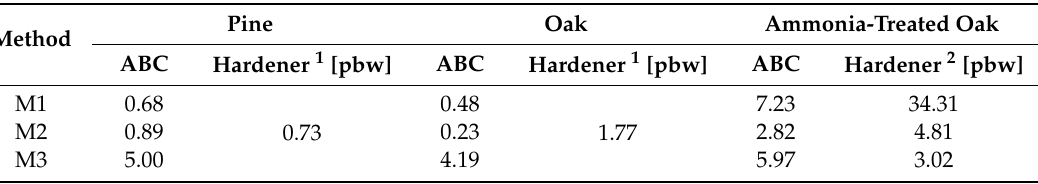
di ff erent raw